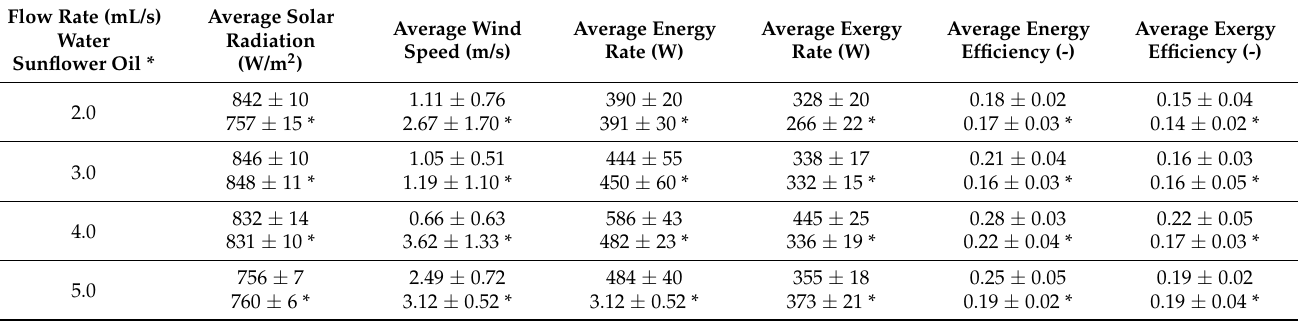
Table 1. Effect of the flow rate on the energetic and exergetic parameters for water and sunflower oil loads during charging cycles with a load of 0.5 kg.